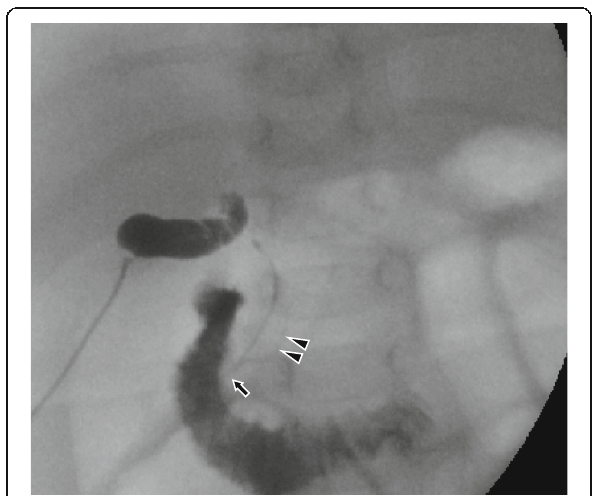
Fig. 2 Intraoperative cholangiogram. A common channel (arrow), common bile duct, and pancreatic duct (arrowhead) can be